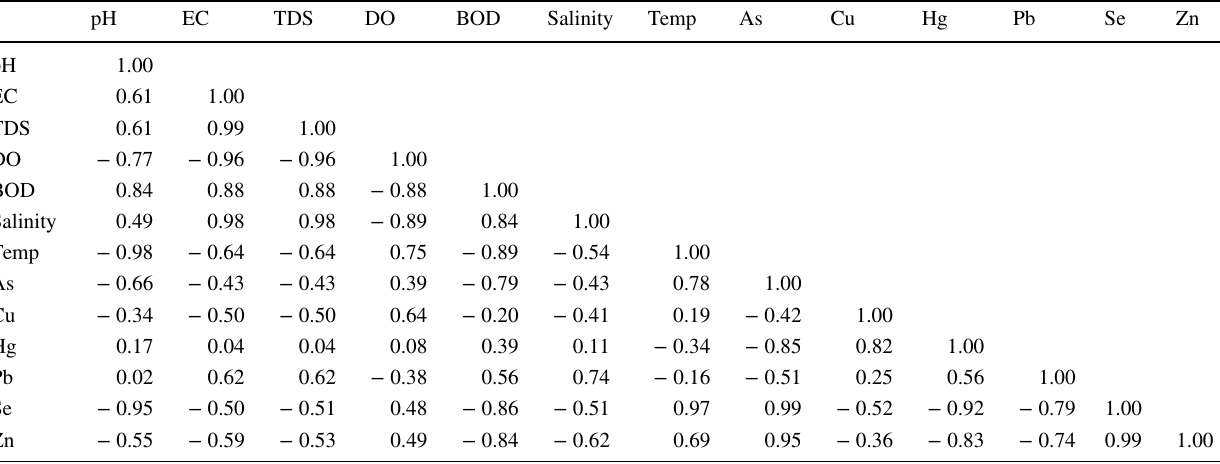
Table 4 Pearson’s correlation coefficient between the physicochemical properties and heavy metal concentration in water samples analyzed in the wet season